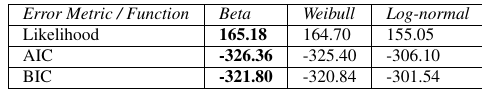
Table 2. PDF fitting error for Sentinel-2